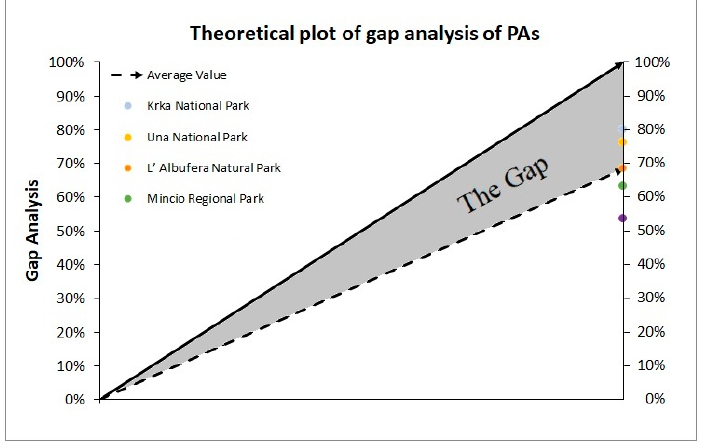
Figure 3. Theoretical plot of average Gap for both fields, for 5 PAs and their individual